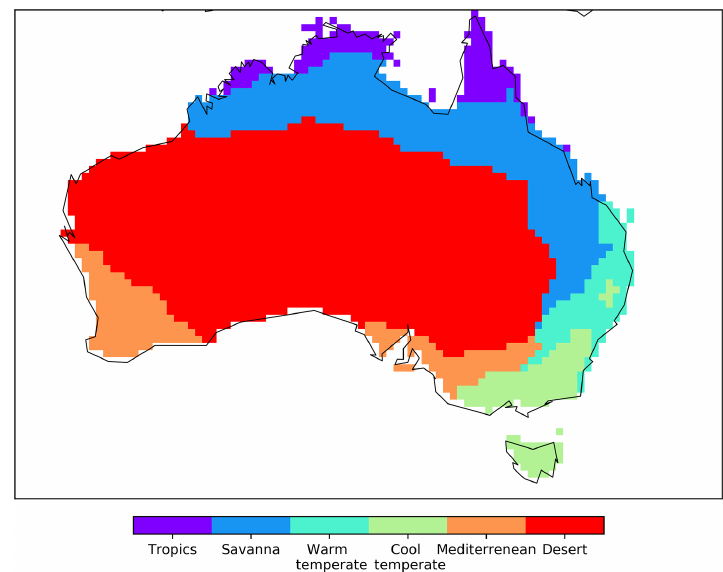
Figure C4. Different vegetation classes in Australia according to Haverd et al. (2012).